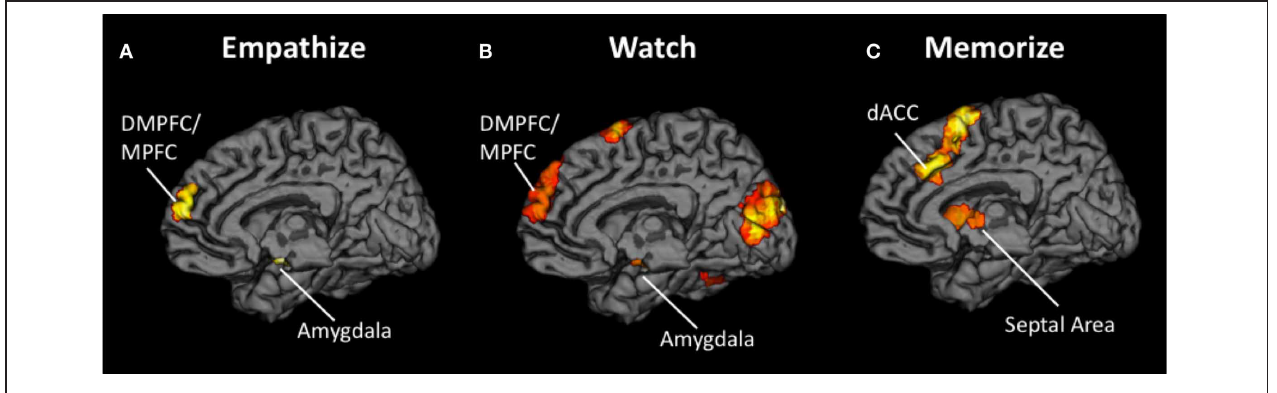
FIGURE 3 | Neural overlap during empathy for happiness, sadness, and anxiety using conjunction analyses for the contrasts (A) Happy Empathize > Neutral, Sad Empathize > Neutral, and Anxiety Empathize > Neutral (B) Happy Watch > Neutral, Sad Watch > Neutral, and Anxiety Watch > Neutral, and (C) Happy Memorize > Neutral, Sad